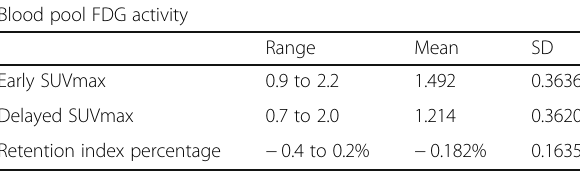
Table 2 Dual point blood pool (IVC lumen) SUVs and retention index percentage in the 50 patients of study population Blood pool FDG activity